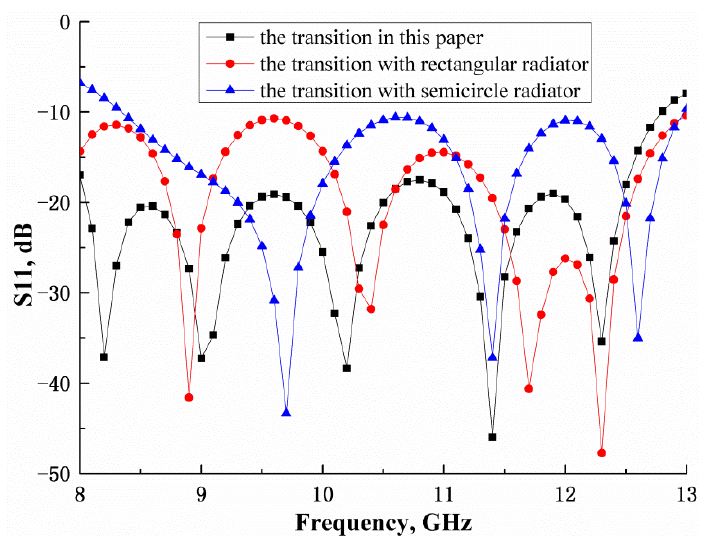
Figure 3. The S-parameter comparison of back-to-back transitions with different radiators.